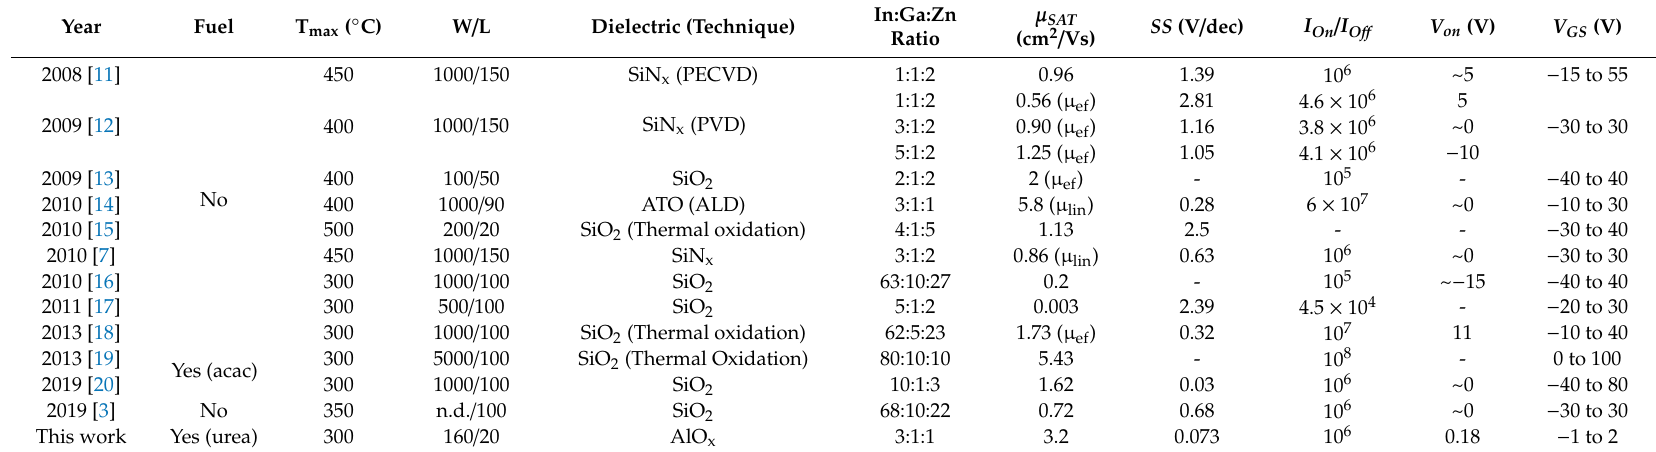
Table 1. Solution-based indium gallium zinc oxide (IGZO) thin film transistors produced at T ≥ 300 ◦ C by spin-coating deposition of 2-methoxyethanol (2-ME) based